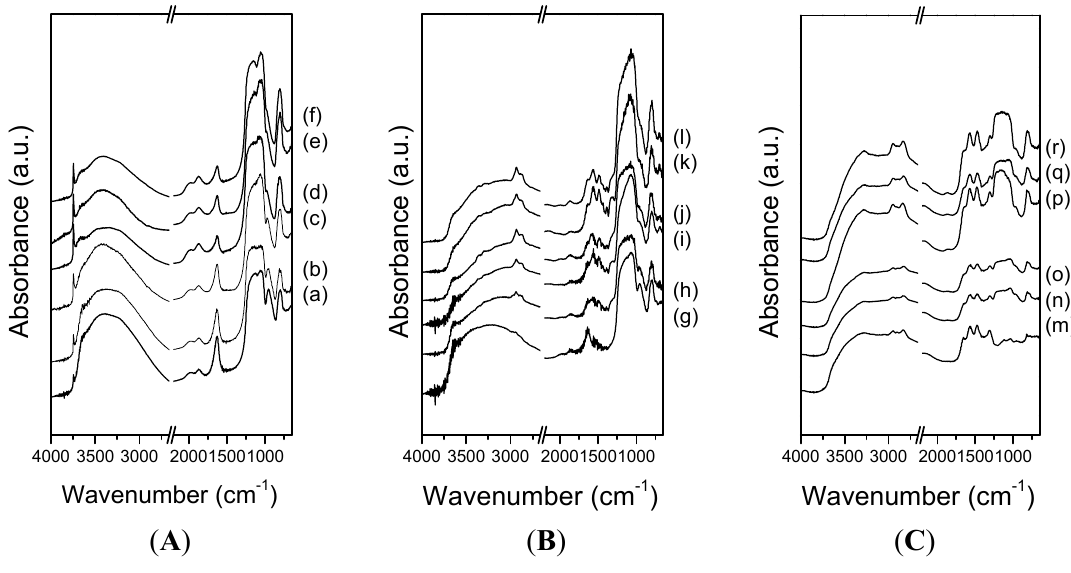
Figure 3. FTIR spectra of ( A ) pure silicas; ( B ) amine grafted silicas and ( C )